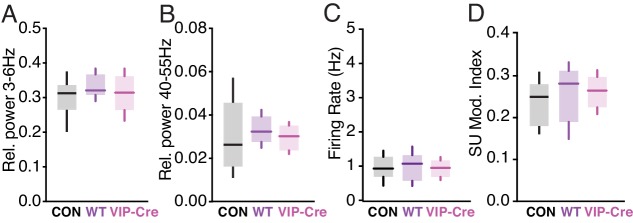
No difference in neural activity among control groups.(A) Cortical relative LFP power in the 3–6 Hz band during quiescent periods in Mecp2f/y controls (black; n = 12), wild-types (magenta; n = 6), and VipCre animals (pink; n = 7). (B) Cortical relative power in the 40–55 Hz band during quiescence. (C) Population-averaged single-unit firing rate of RS cells during quiescence in Mecp2f/y controls (n = 7), wild-types (n = 9), and VipCre controls (n = 7). (D) Modulation of single-unit firing rate in each group at locomotion onset, measured as an index value.